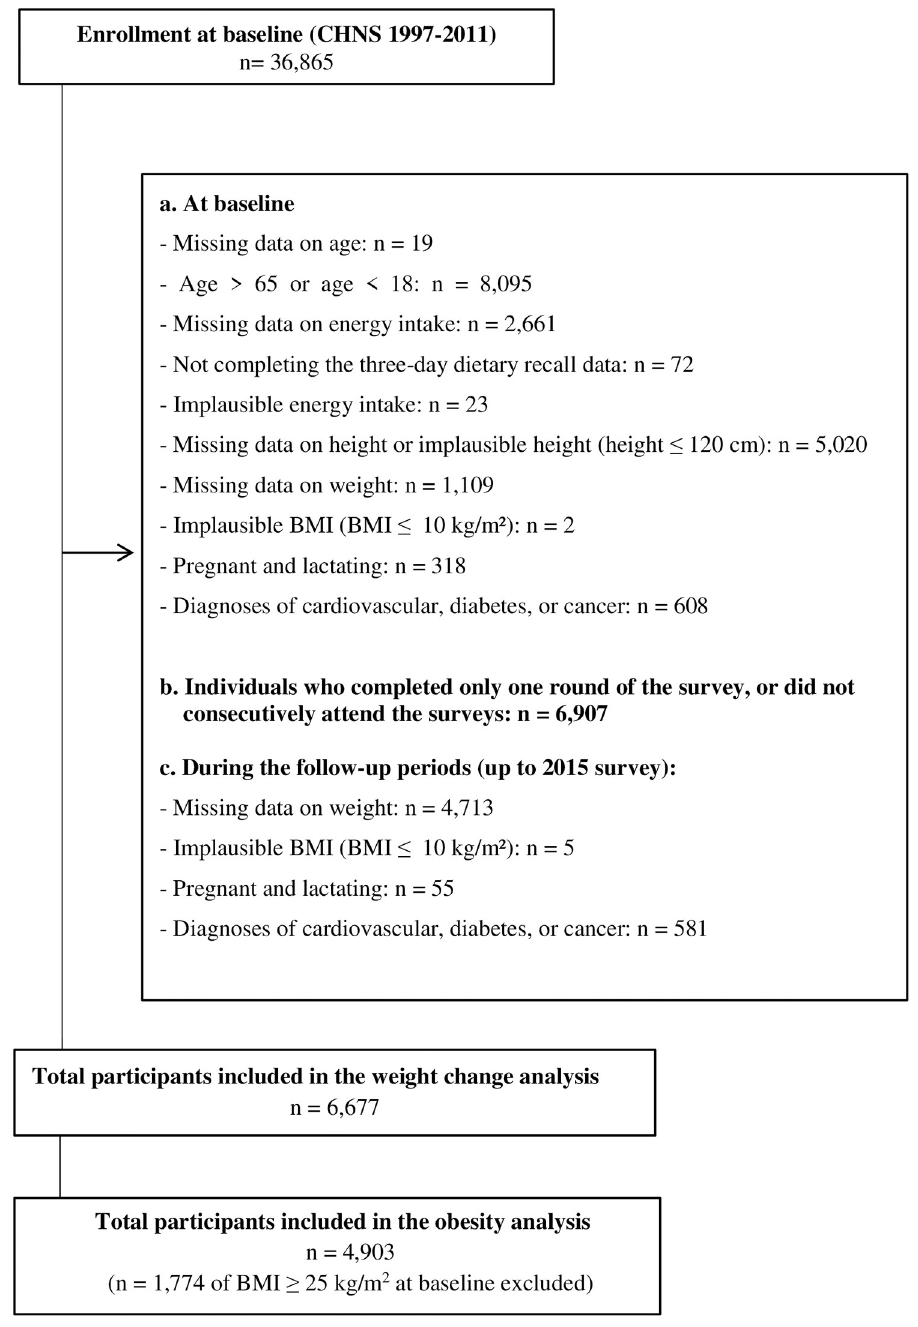
Fig 1. Flowchart of participants included in the study (CHNS